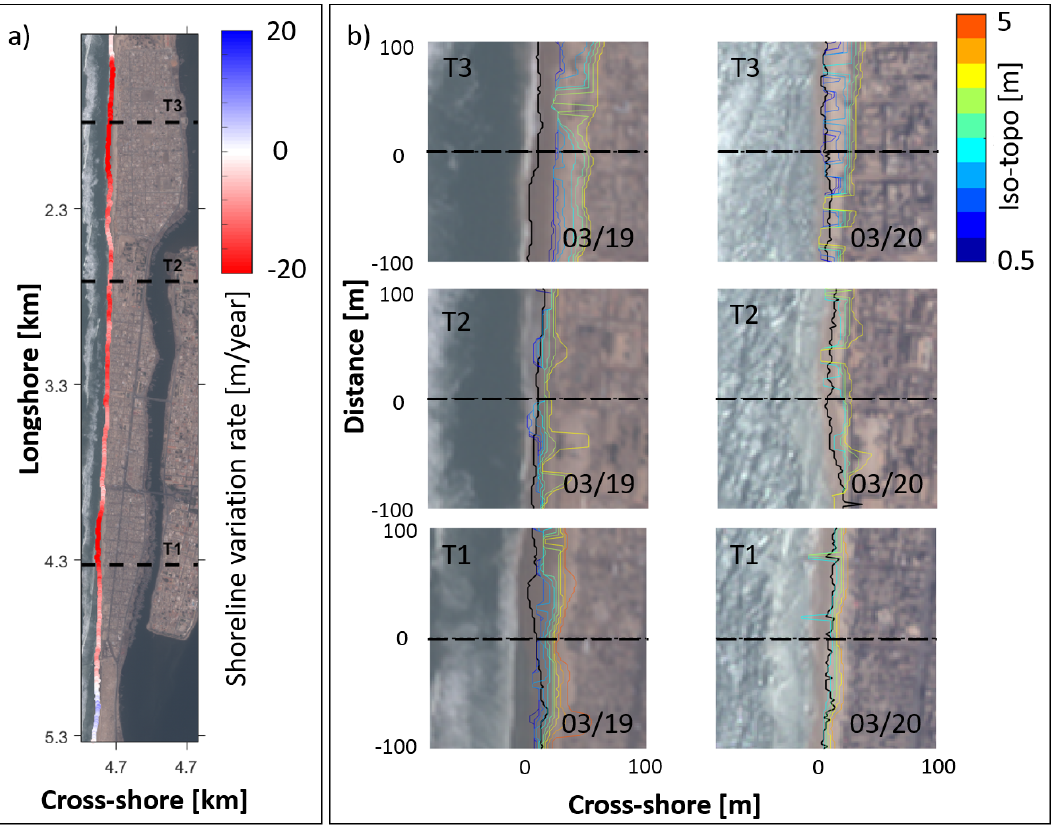
Figure 3. ( a ) Erosion rate within a year derived from Pleiades images in the urban area—calculated from the difference between the waterlines position of 2019 and 2020. ( b ) Iso-topographies derived from Pleiades onto the chosen transects which height ranging from 0.5 m to 5 m (color lines), and associated waterline position (black